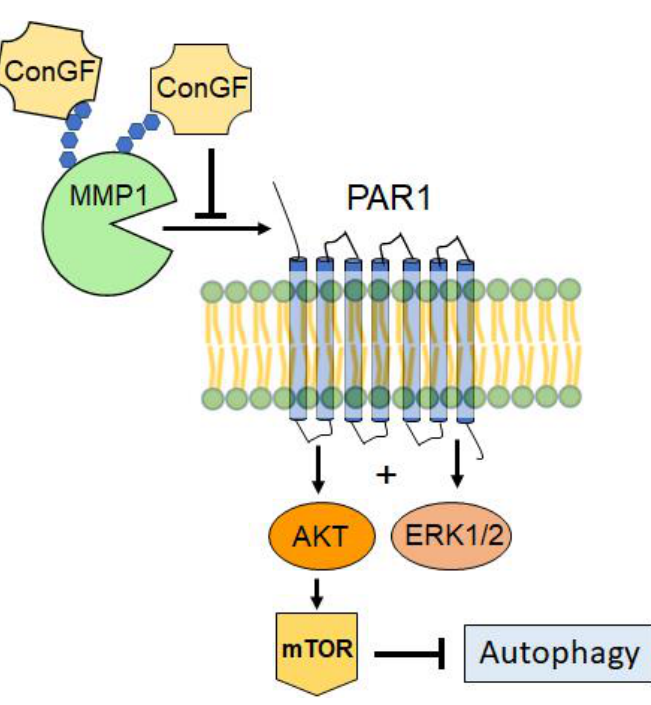
Figure 7. Postulated mechanism for ConGF activity via MMP1 interaction.